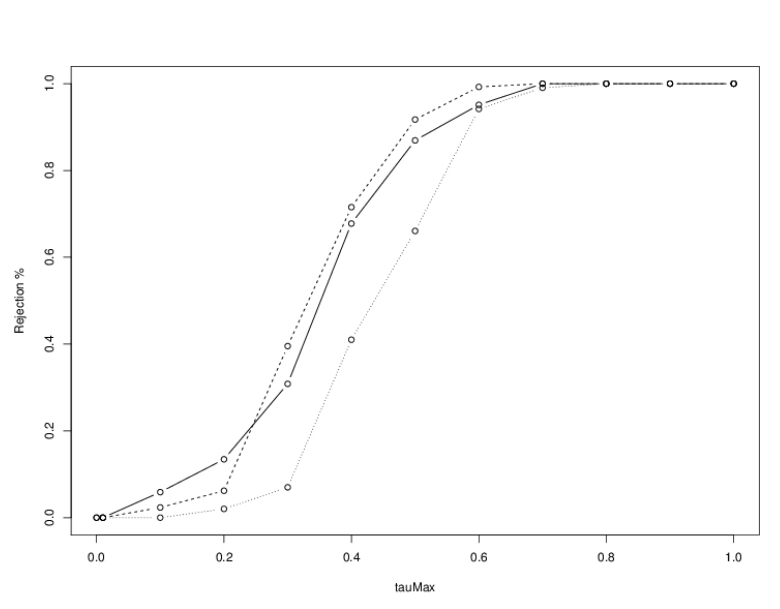
Figure 3: Rejection percentages for the statistics T c 2 (18) as a function of τ max : we use the gaussian copula, with a conditional parameter θ ( x ) calibrated such that the conditional Kendall’s tau τ ( x ) satisfies τ ( x ) = τ max · Φ ( x ) . Solid line: bootNP. Dashed line : bootPI. Dotted line :